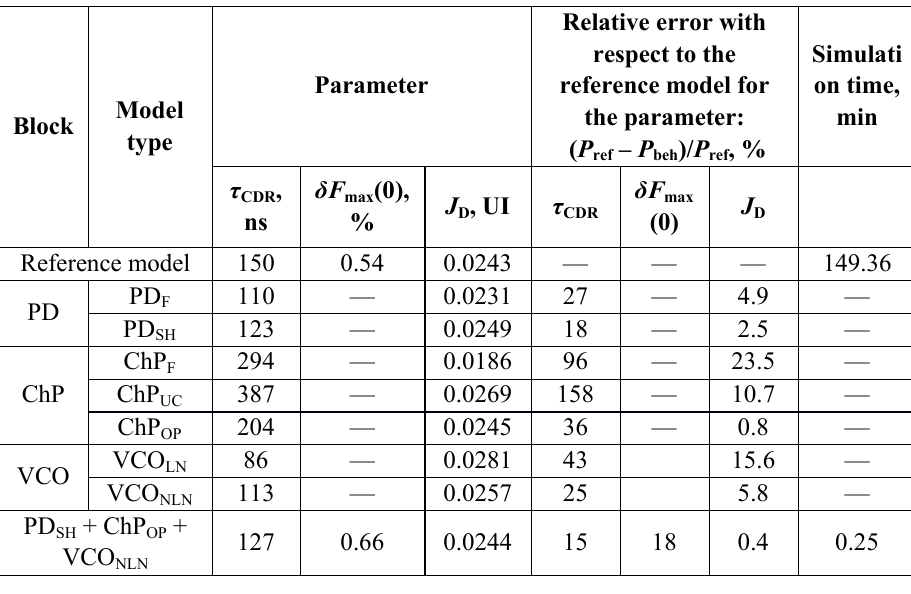
Table 2. Comparison of simulation results.